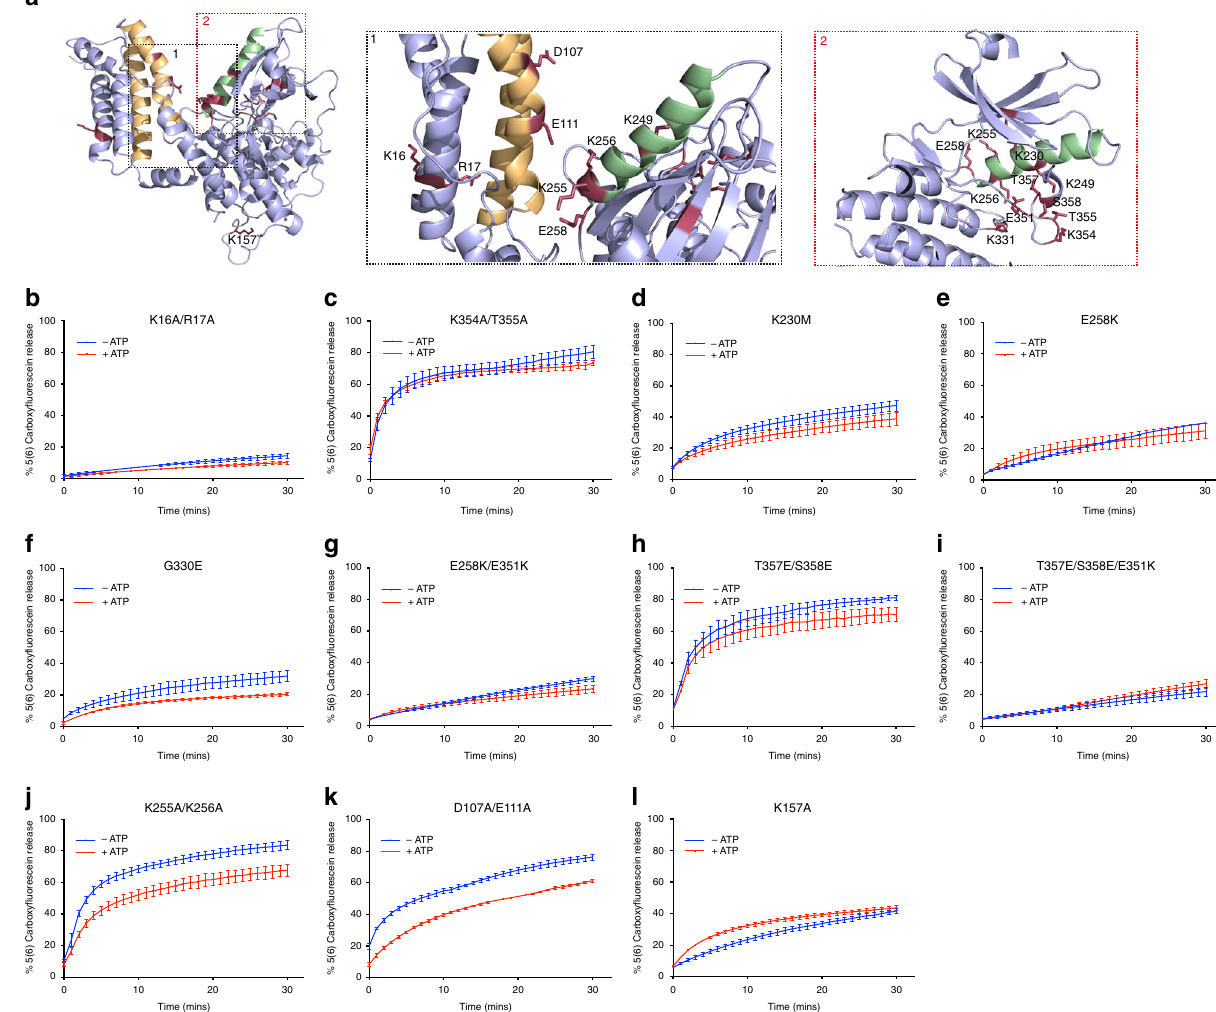
Fig. 4 hMLKL(2 – 471) liposome permeabilization activity is affected by PsK domain mutations that disrupt the molecular switch. a Residues mutated in the present study are shown as sticks on the E351K hMLKL model generated in the course of this study (Fig. 2a), with zoomed views of the 4HB-PsK interface (panel 1) and the pseudoactive site in the PsK domain (panel 2) shown on the right. b – l 5(6)-Carboxy fl uorescein egress from liposomes induced by 1 μ M full-length hMLKL in the presence (red) and absence (blue) of 500 μ M ATP was monitored by absorbance at 485 nm for K16A/R17A ( b ), K354A/T355A ( c ), K230M ( d ), E258K ( e ), G330E ( f ), E258K/E351K ( g ), T357E/S358E ( h ), T357E/S358E/E351K ( i ), K255A/K256A ( j ), D107A/E111A ( k ), and K157A ( l )